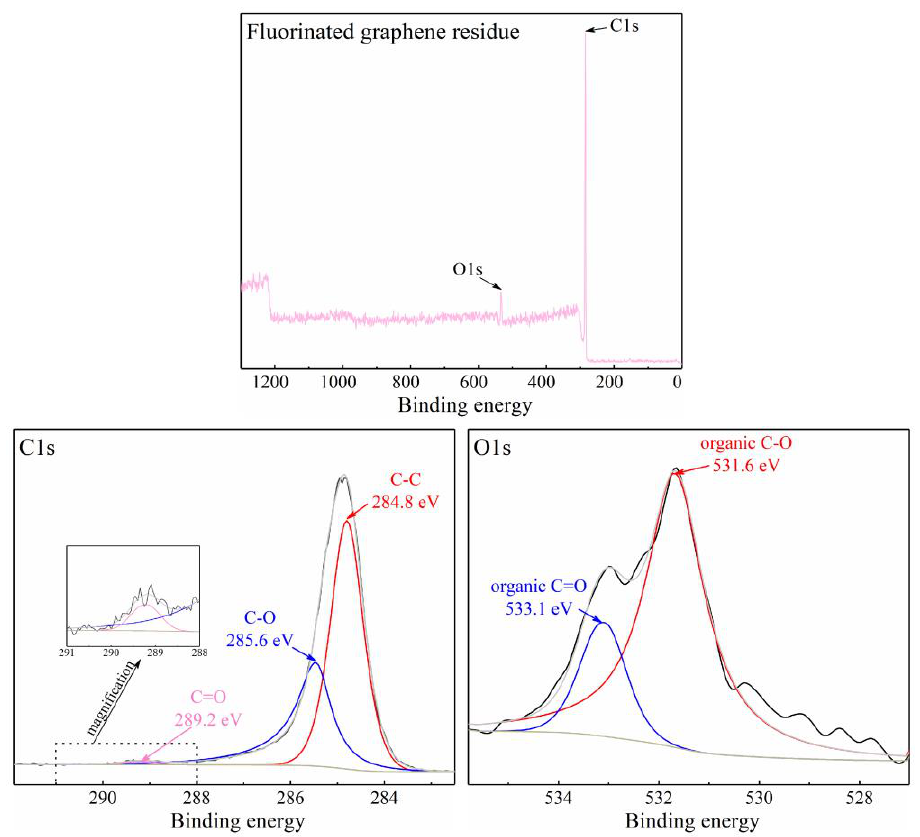
Figure 7. The XPS spectra of the fluorinated graphene residue after TG-DSC experiment. The black line is the original data and the grey line is the fitting data.